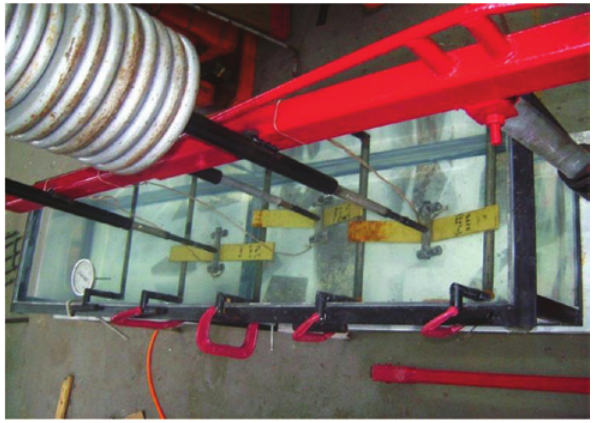
Figure 1: Creep testing